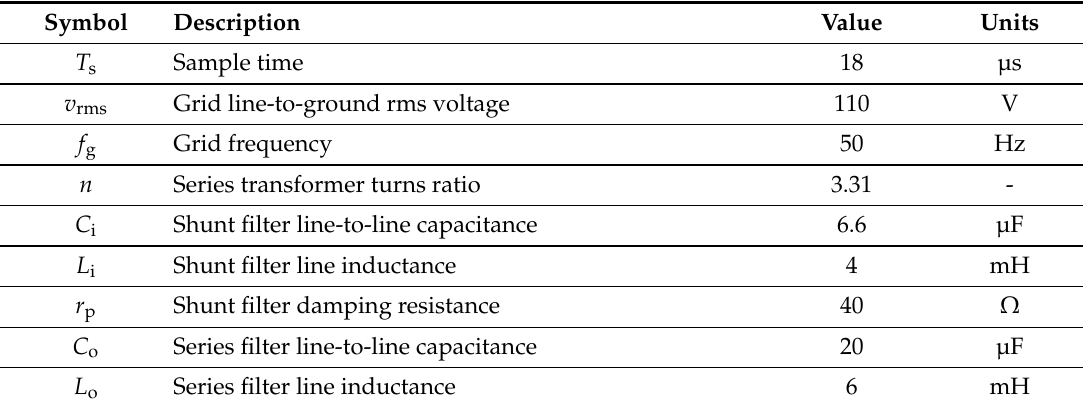
Table 5. System parameter values.